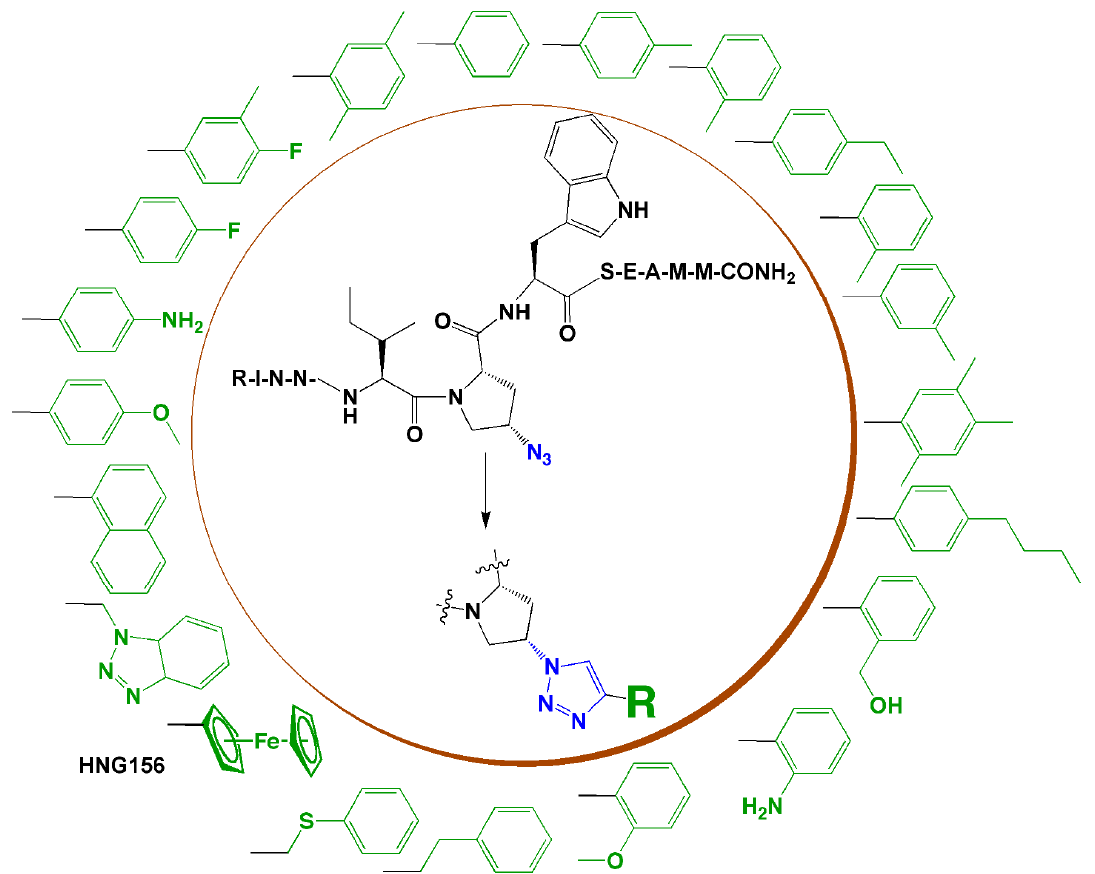
Figure 4. A family of HIV-1 Env antagonist 4-aryl 1,2,3-triazole peptides synthesized via click cycloaddition.